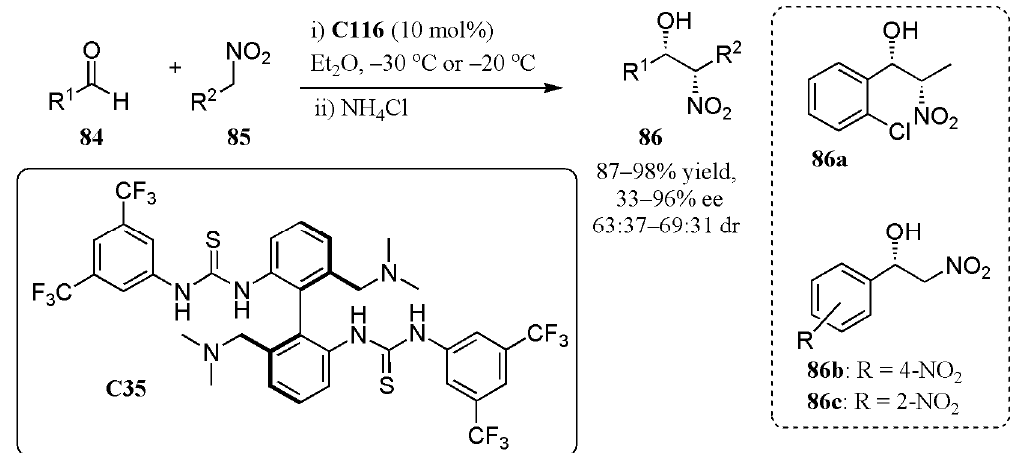
Figure 45. Asymmetric Henry reaction catalyzed by C35 [89].